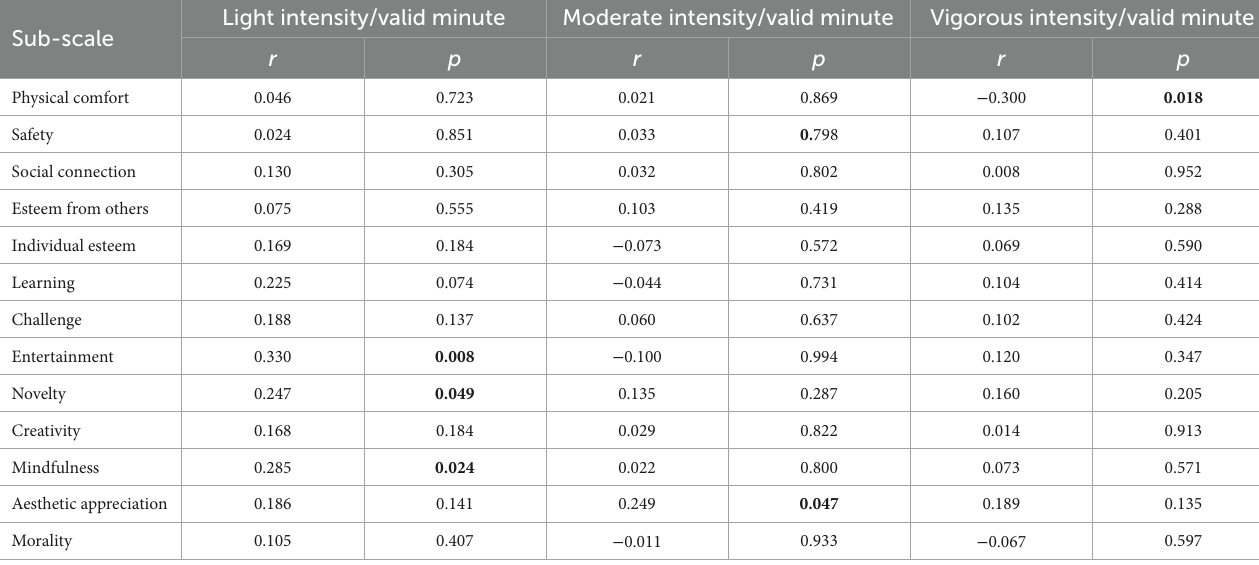
TABLE 6 Bivariate correlations of psychological needs satisfied through physical activity with device-based physical activity behavior.